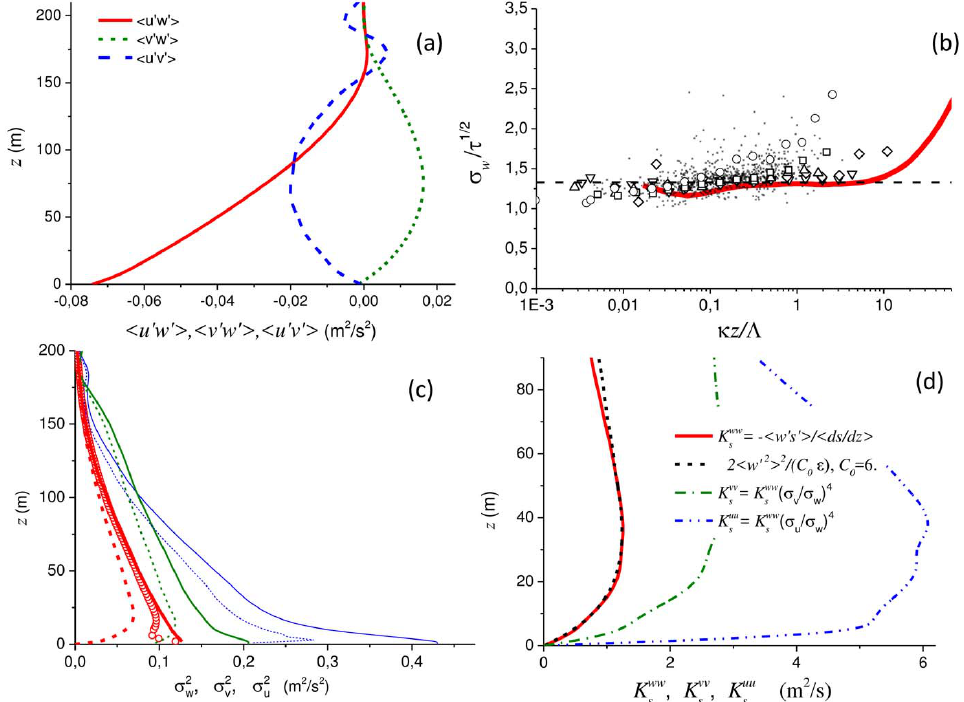
D E 1 / 2 ; symbols – measurements + 2 / 3 E w ∗ 2 subgr )